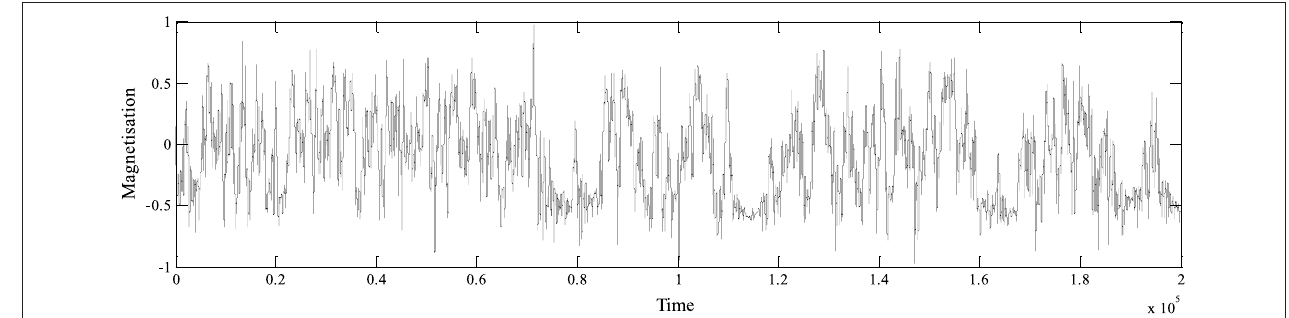
FIGURE 5 | The full run (200,000 time units) generated by the IL model with 15 disk dynamos.